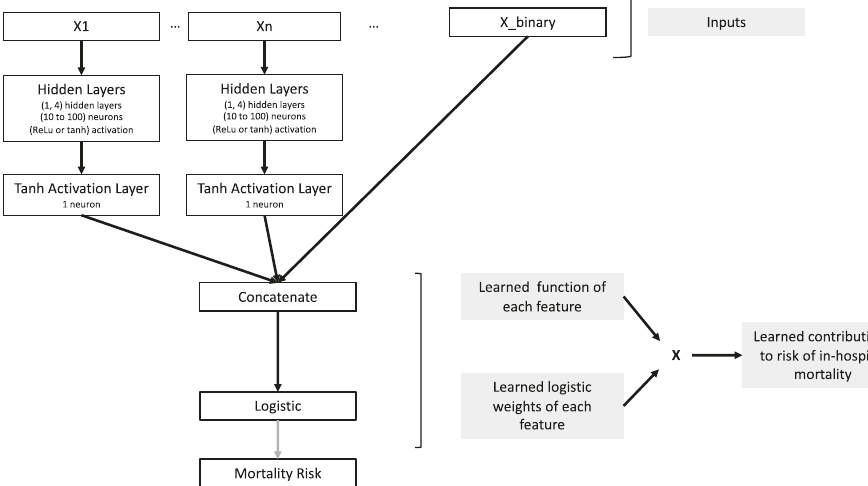
Fig. 3 Proposed generalized additive models with neural networks architecture. This fi gure describes feature contributions calculation, for n individual continuous features (X1, … ,X n ) vs binary features